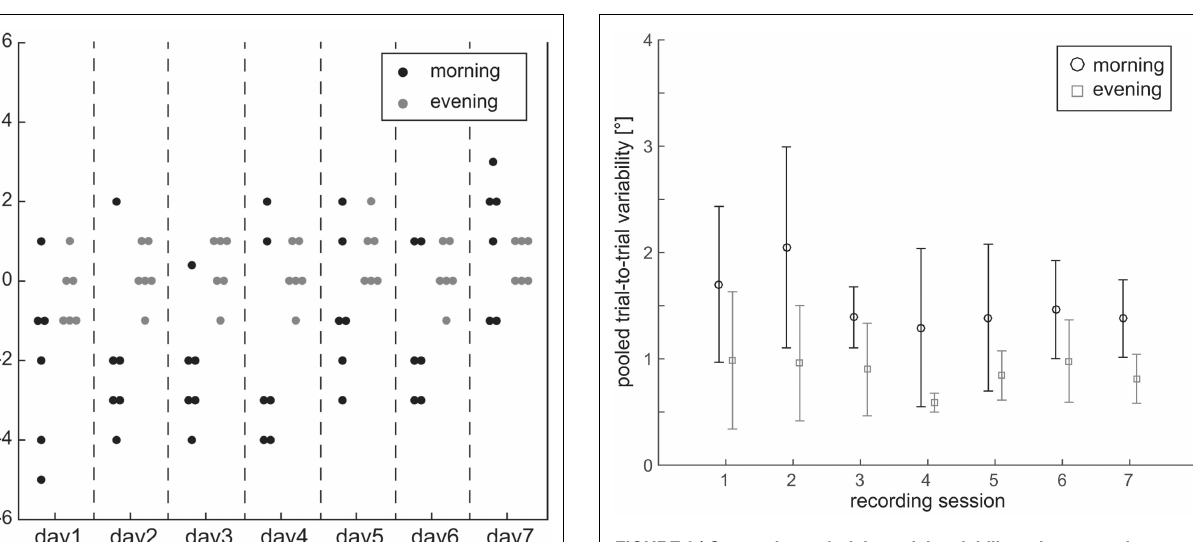
FIGURE 3 | Comparison of trial-to-trial variability values over the 7days of data acquisition both in the morning (black circles) and in the evening (gray squares) for all seven subjects . Statistical analysis showed no significant differences in variability between the seven recording sessions – this was true for both morning and evening